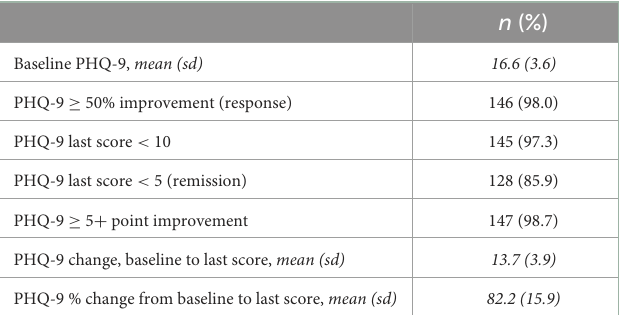
TABLE 6 PEARLS depression outcomes ( N = 149) a